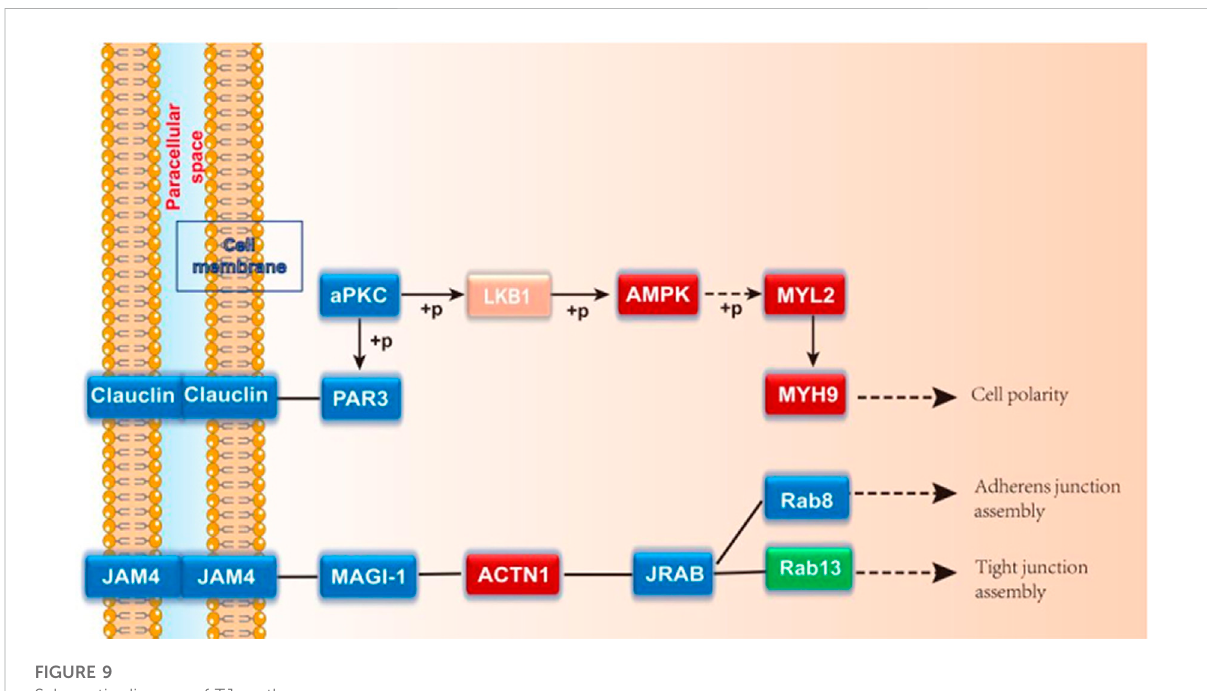
FIGURE 9 Schematic diagram of TJs